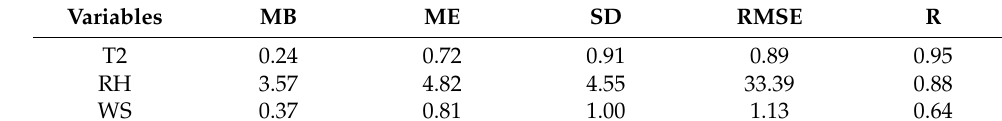
Table 5. Evaluations of the meteorological simulations in Guangzhou.